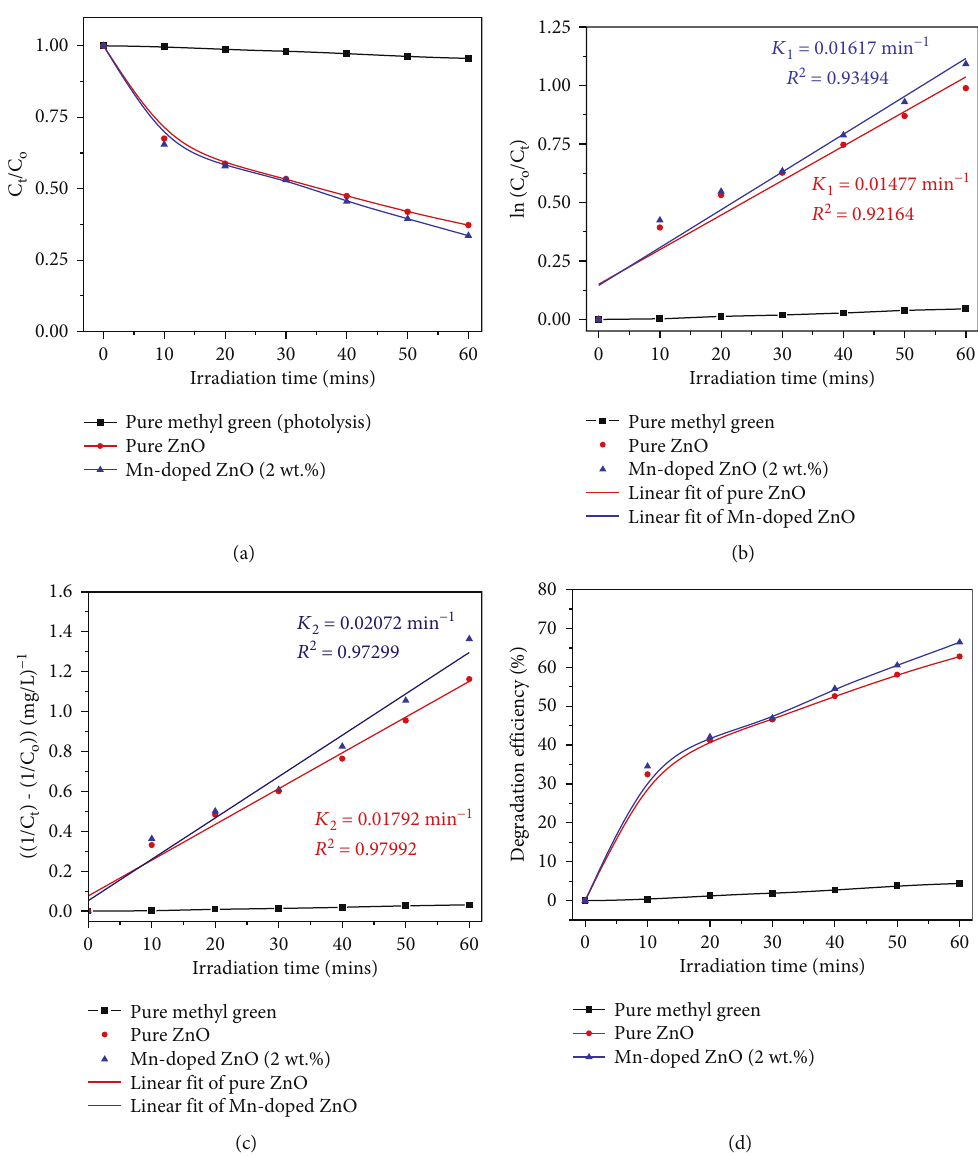
C t / o curves, (b) plot of